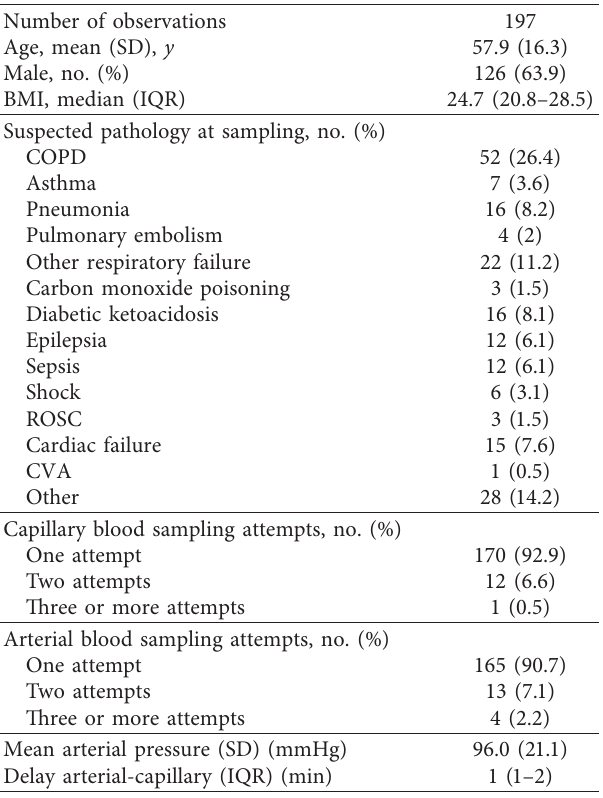
Figure 1: Inclusion flowchart showing the screening, exclusion, and analysis Table 1: Demographic and clinical characteristics of patients at study inclusion.